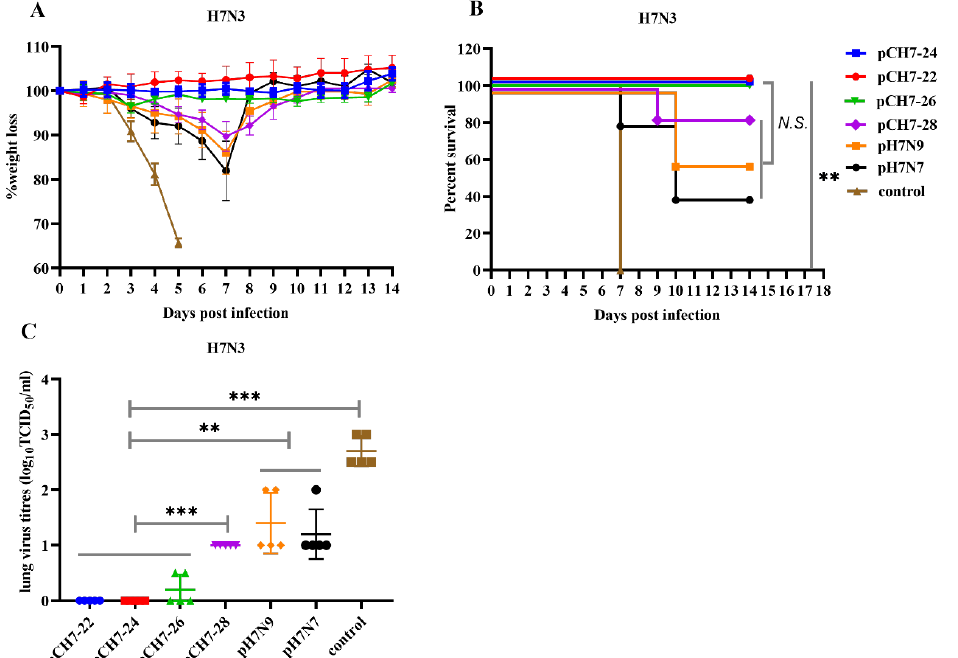
Figure 8. DNA vaccination with consensus H7 confers protection against lethal H7N3 influenza virus challenge in mice. Groups of mice were vaccinated twice with pCH7-22, pCH7-24, pCH7-26, pCH7-28, pH7N7, or pH7N9 and challenged with 10 × LD50 mouse-adapted A / Chicken / BC / CN006 / 2004 (H7N3) from the North American lineage virus at 3 weeks after the second immunization. Changes in body weight ( A ) and survival rates ( B ) were monitored daily for 2 weeks post-infection. Four mice from each group were sacrificed at day 5 post-infection, and lungs were collected for virus titration ( C ). The statistical analysis of survival rate di ff erence between groups was performed with a Fisher’s Exact test. The statistical analysis of viral titers was analyzed by t test. p values shown in bar charts and N.S. indicates no significance between two compared groups. ** p < 0.01 and *** p < 0.001 between indicated groups.